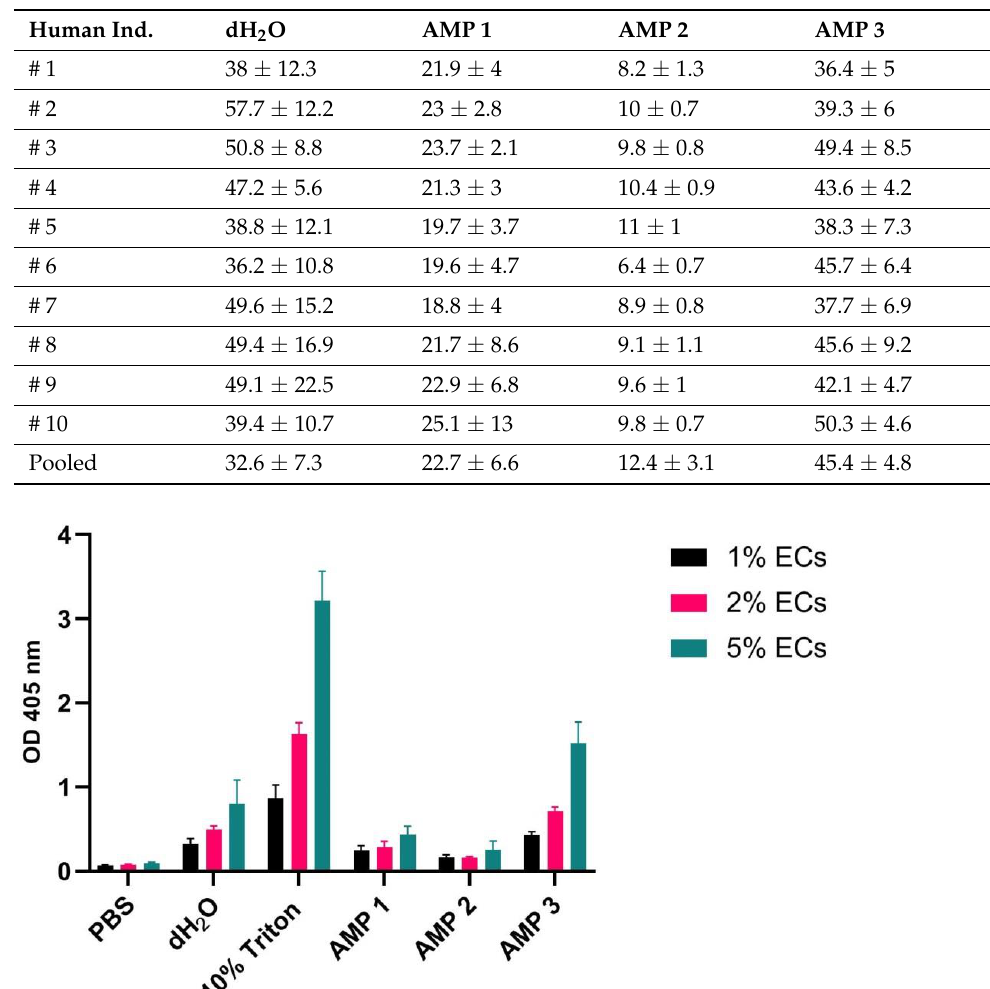
Table 2. Calculated hemolysis ratios (in %) according to Equation (1) for dH 2 O and AMPs 1, 2, and 3 when testing 1% erythrocytes from different human individuals as well as a sample consisting of pooled blood from all 10 individuals. Normalization was performed on data averaged from three experimental replicates, each containing two technical replicates, and using 10% Triton X and PBS samples as positive and negative control, respectively.